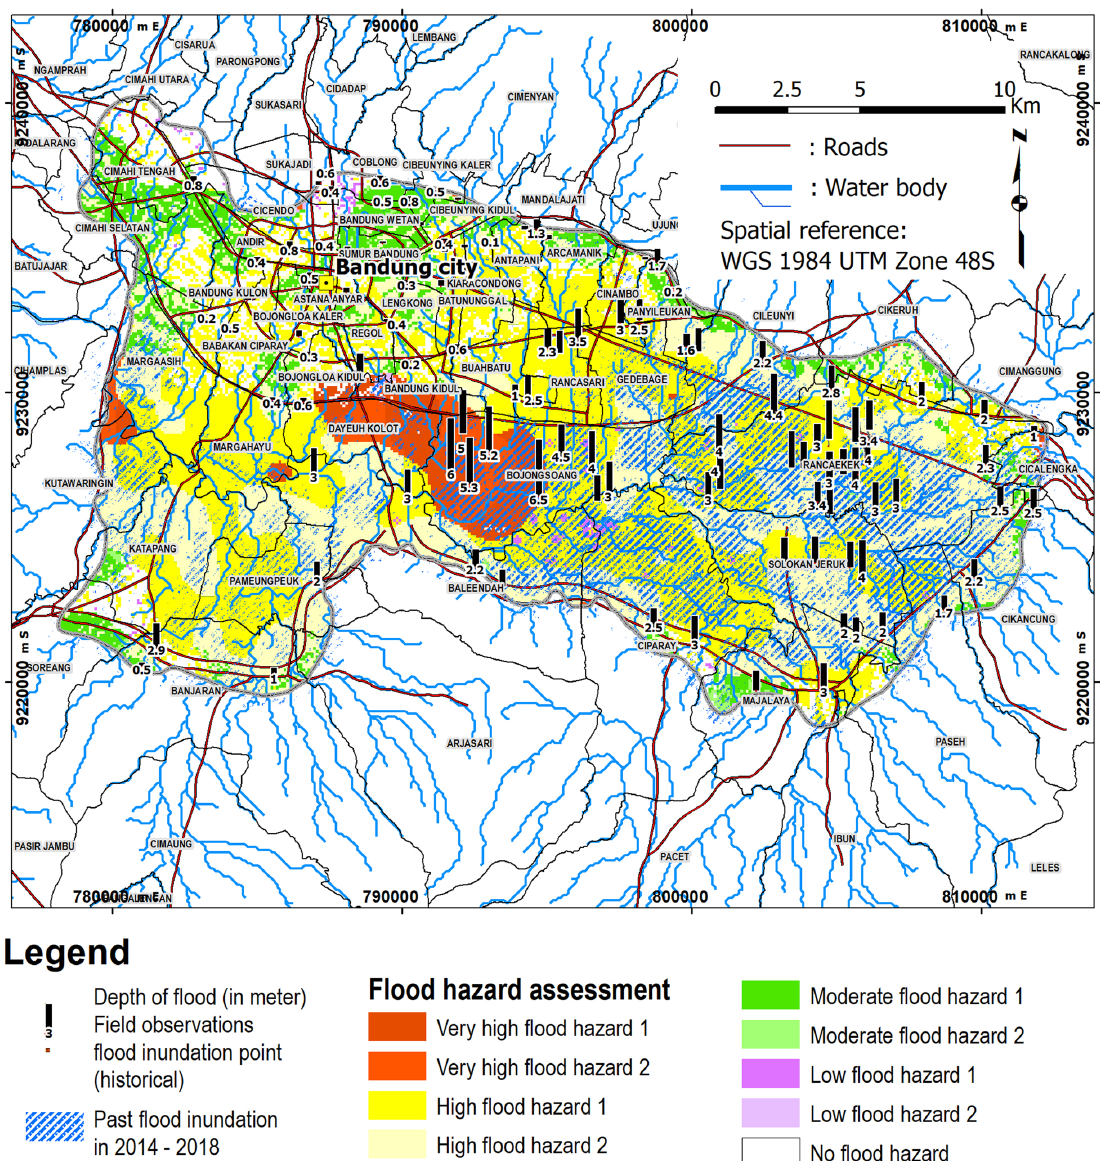
Fig. 10. The result of flood hazard assessment and mapping based on the integration of TSC as a micro- landform classification approach, probability map for flood inundation and flood depths from field